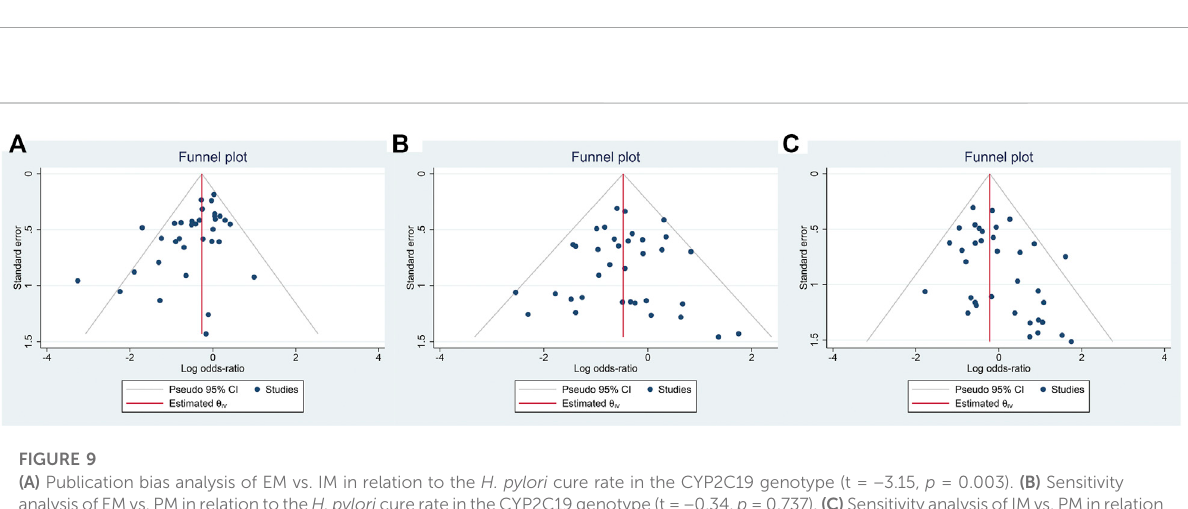
FIGURE 8 (A) SensitivityanalysisofEMvs.IMinrelationtothe H.pylori curerateintheCYP2C19genotype. (B) SensitivityanalysisofEMvs.PMinrelationto the H. pylori cure rate in the CYP2C19 genotype. (C) Sensitivity analysis of IM vs. PM in relation to the H. pylori cure rate in the CYP2C19 genotype.